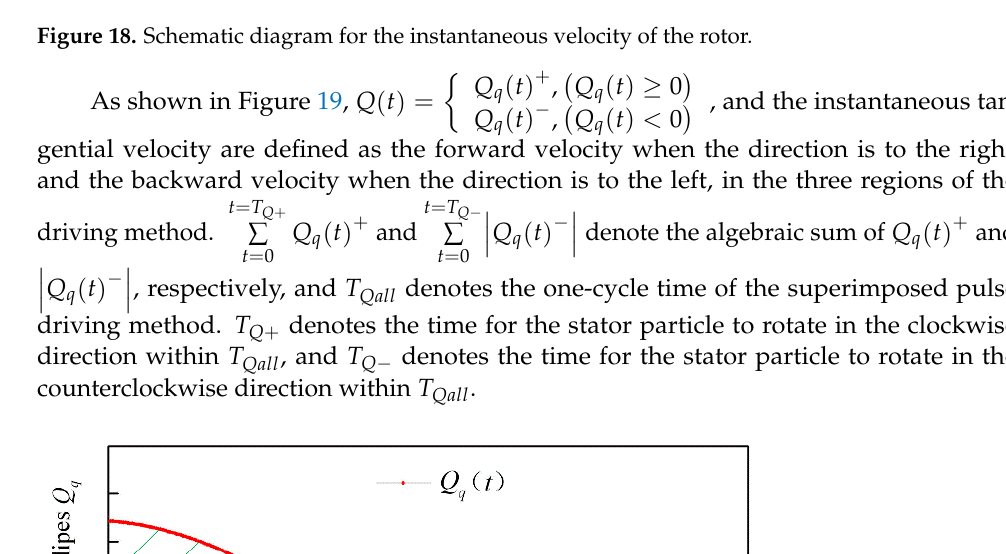
Figure 19. Schematic diagram of determining factors for the direction of the motion.